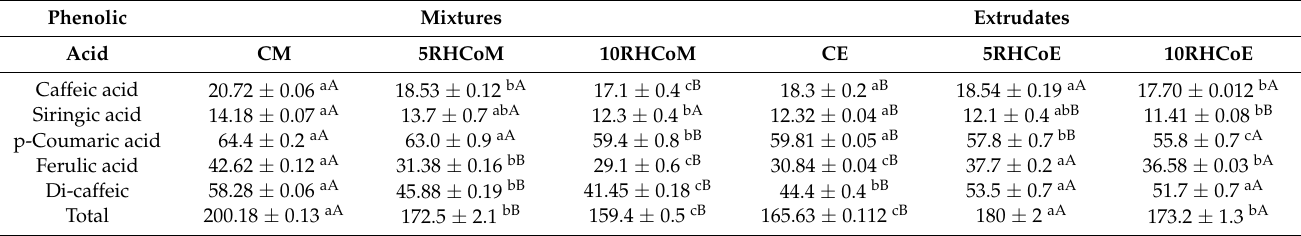
For each parameter, different small letter in superscript within row indicates significant differences between samples ( p < 0.05) comparing samples in mixtures or extrudates. For each sample and parameter, a different capital letter in superscript within row indicates significant differences between samples ( p < 0.05) comparing mixtures and extrudates. Samples were mixtures (M) and extrudates (E); C: Control, 5RHCo: 5% of rosehip co-product and 10RHCo: 10% of rosehip